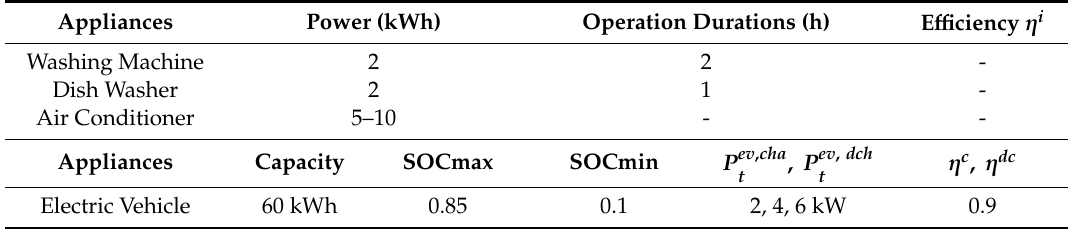
Table 2. Parameters of the